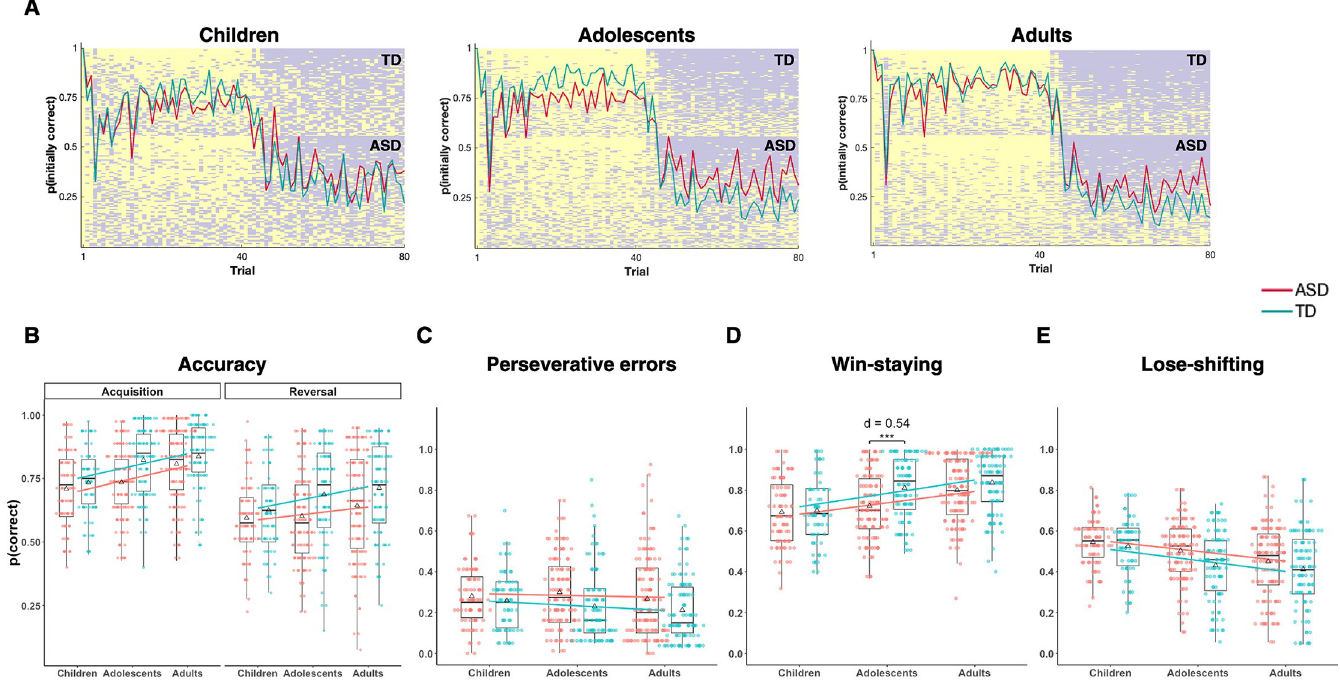
Fig 2. Task behavior. (A) Trial-by-trial data for each age group with diagnostic group averages overlaid. More evidence of task understanding in adults, as indicated by more correct task behavior and steeper shifts at reversal in comparison to children. (B) Task accuracy was greater (1) in the acquisition phase compared to the reversal phase, (2) in older age groups compared to younger, and (3) in TD individuals compared to ASD individuals. (C-E) Linear mixed-effects models showed a main effect of diagnosis for all three task performance measures (perseverative errors, win-staying, lose-shifting) and a main effect of age for win-staying (D) and lose-shifting (E) but not perseverative errors (C). For win-staying, a diagnosis × age group interaction was also found. Post hoc tests revealed ASD adolescents showed significantly reduced win-staying compared with TD adolescents (D), ��� p < .001 (see S1 Data). ASD, autism spectrum disorder; TD, typical development.